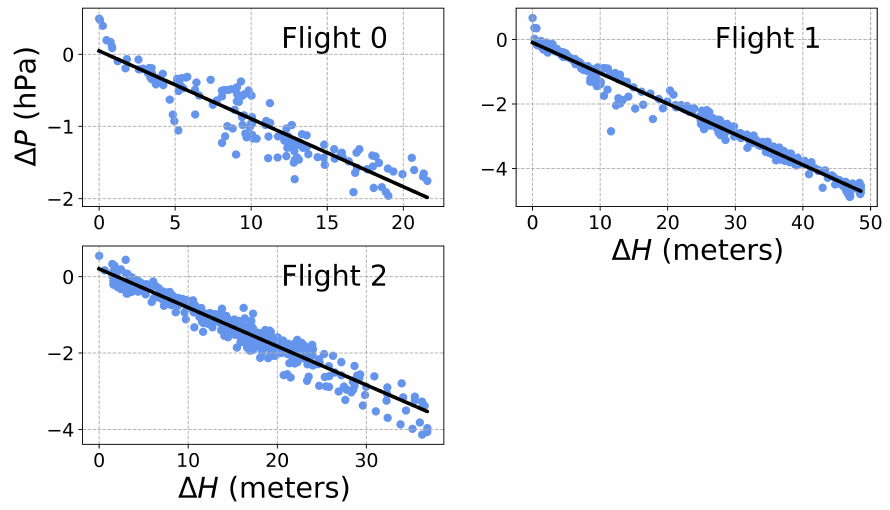
Figure 7. Pressure vs. altitude for the three flights from Figure 6. The black lines show linear fits for each launch.